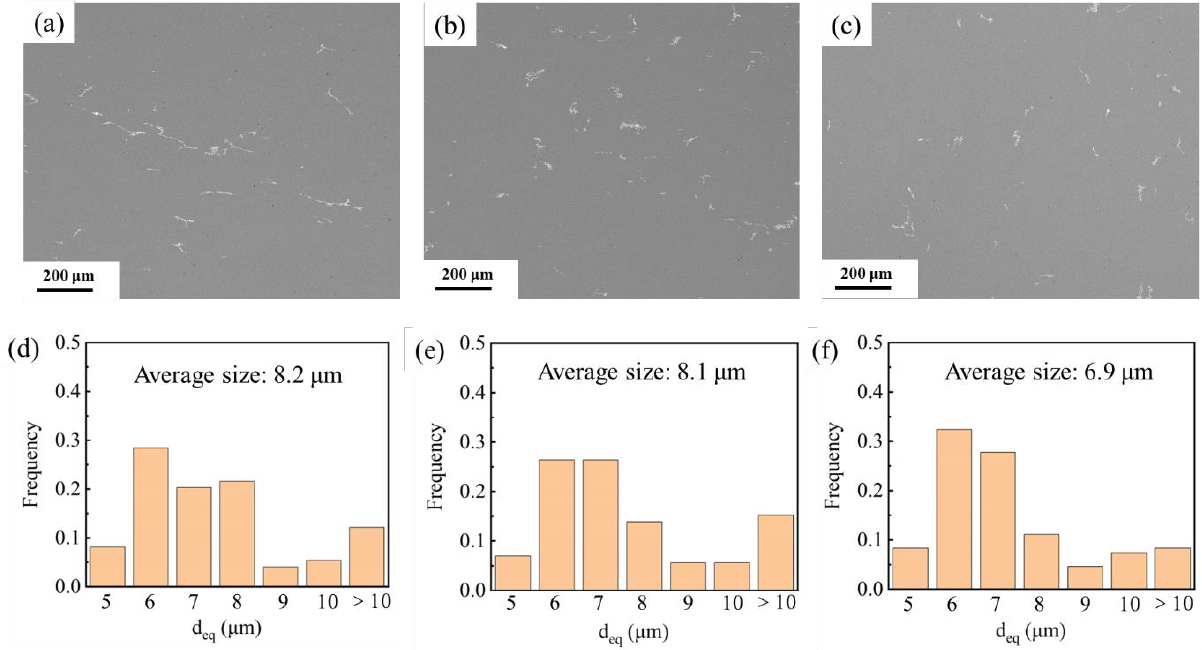
Figure 7. SEM images and particle size distribution of the 7085 alloys after T6 heat treatment: ( a , d ) HTD; ( b , e ) MTD; ( c , f ) CTD.